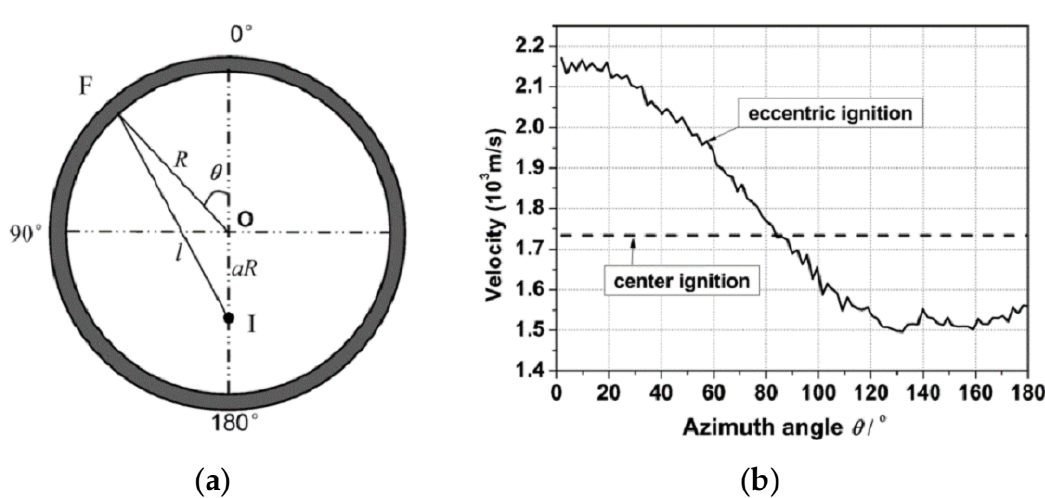
Figure 11. Schematic diagram of the eccentric ignition and fragment velocity curve (From the literature [1]). ( a ) Schematic diagram of the eccentric ignition of the cylindrical warhead; ( b ) velocity curve of fragments under eccentric ignition and center